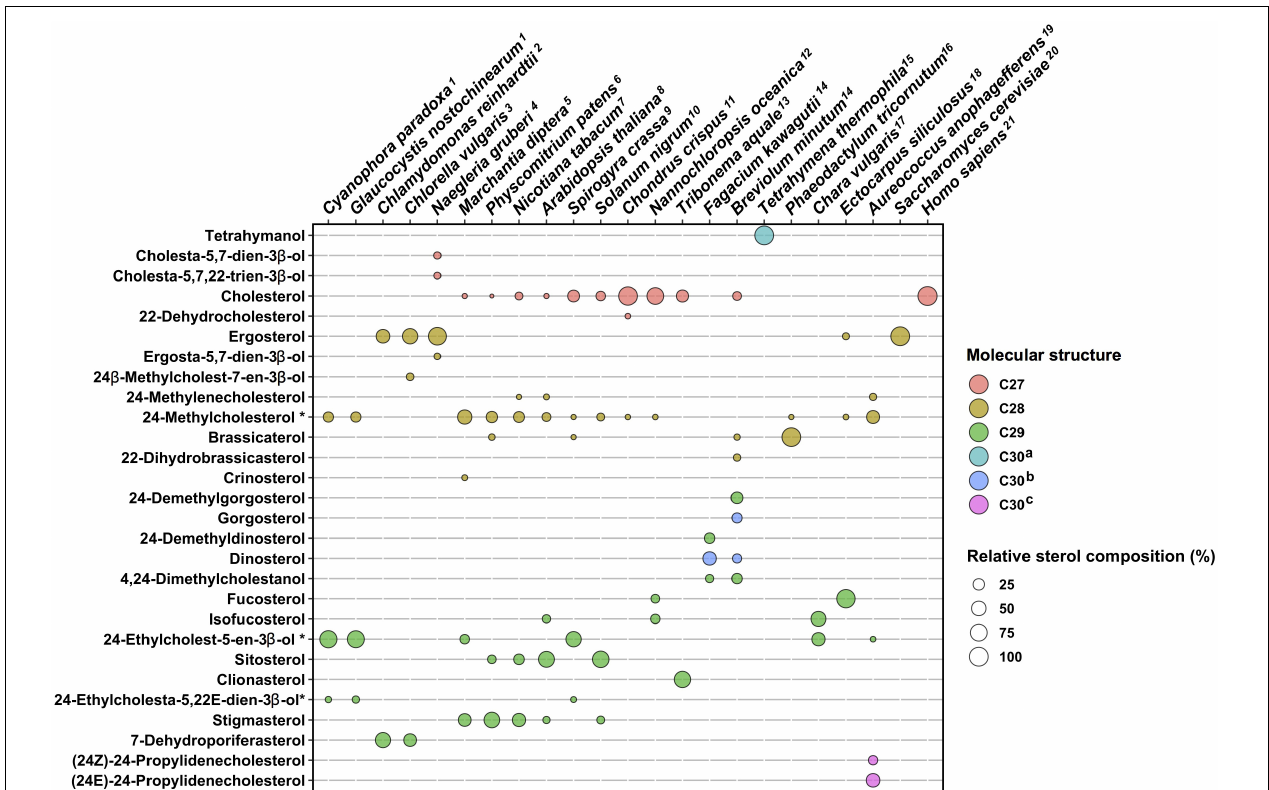
FIGURE 4 | Sterol profiles in algae and plants. Sterol compositions of twenty species are plotted on a schematic diagram, which indicates proportions in percent and molecular structures by color codes. C 27 , sterols bearing a C 8 -side chain (e.g., cholesterol); C 28 , C 9 -side chain (e.g., ergosterol); and C 29 , C 10 -side chain (e.g., fucosterol). C 30 a , C 30 H 50 O direct cyclization products of (3 S )-2,3-oxidosqualene (e.g., tetrahymanol). C 30 b , sterol products with additional methyl groups on the tetracyclic moiety and on the side chain (e.g., dinosterol). C 30 c , sterol products with a C 11 -side chain (e.g., propylidene sterols). Sterol compositions as percent